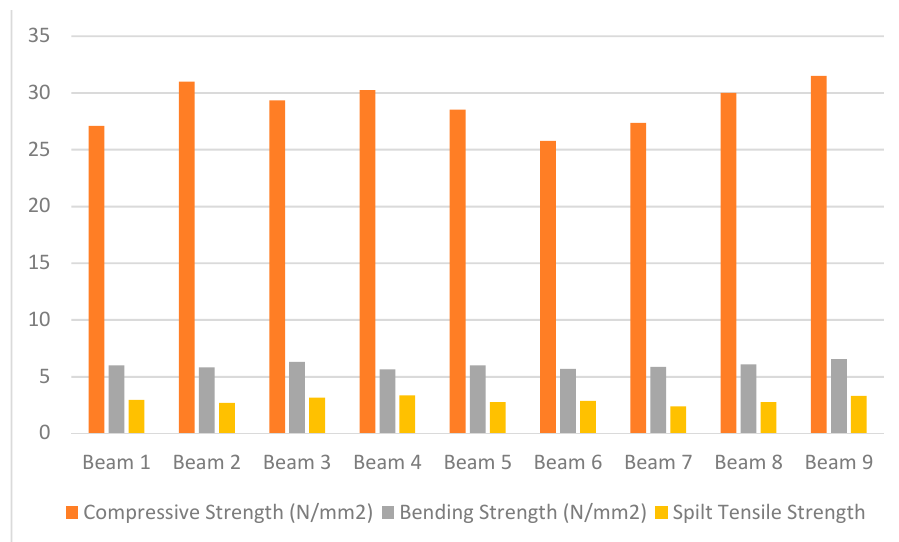
Figure 6. Characteristics of specimens used [60].